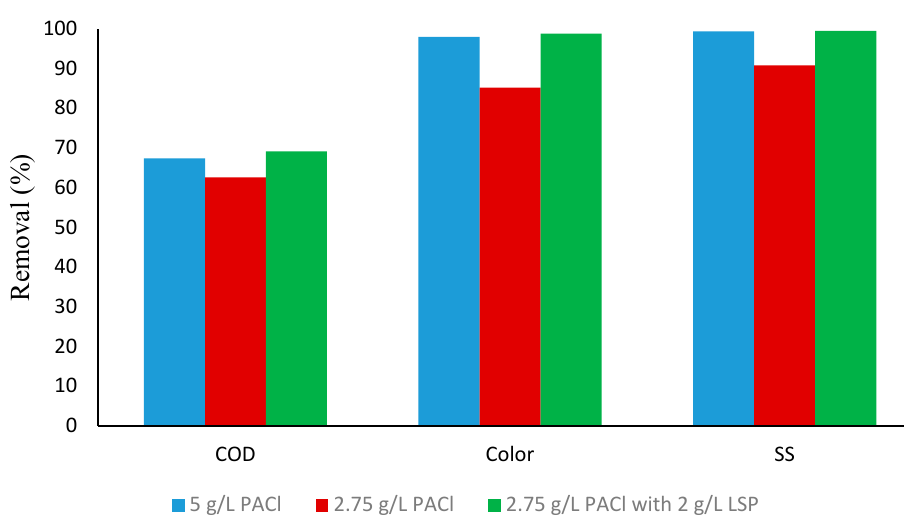
Figure 10. Comparison of using PACl alone and PACl in conjunction with LSP as a coagulant aid.